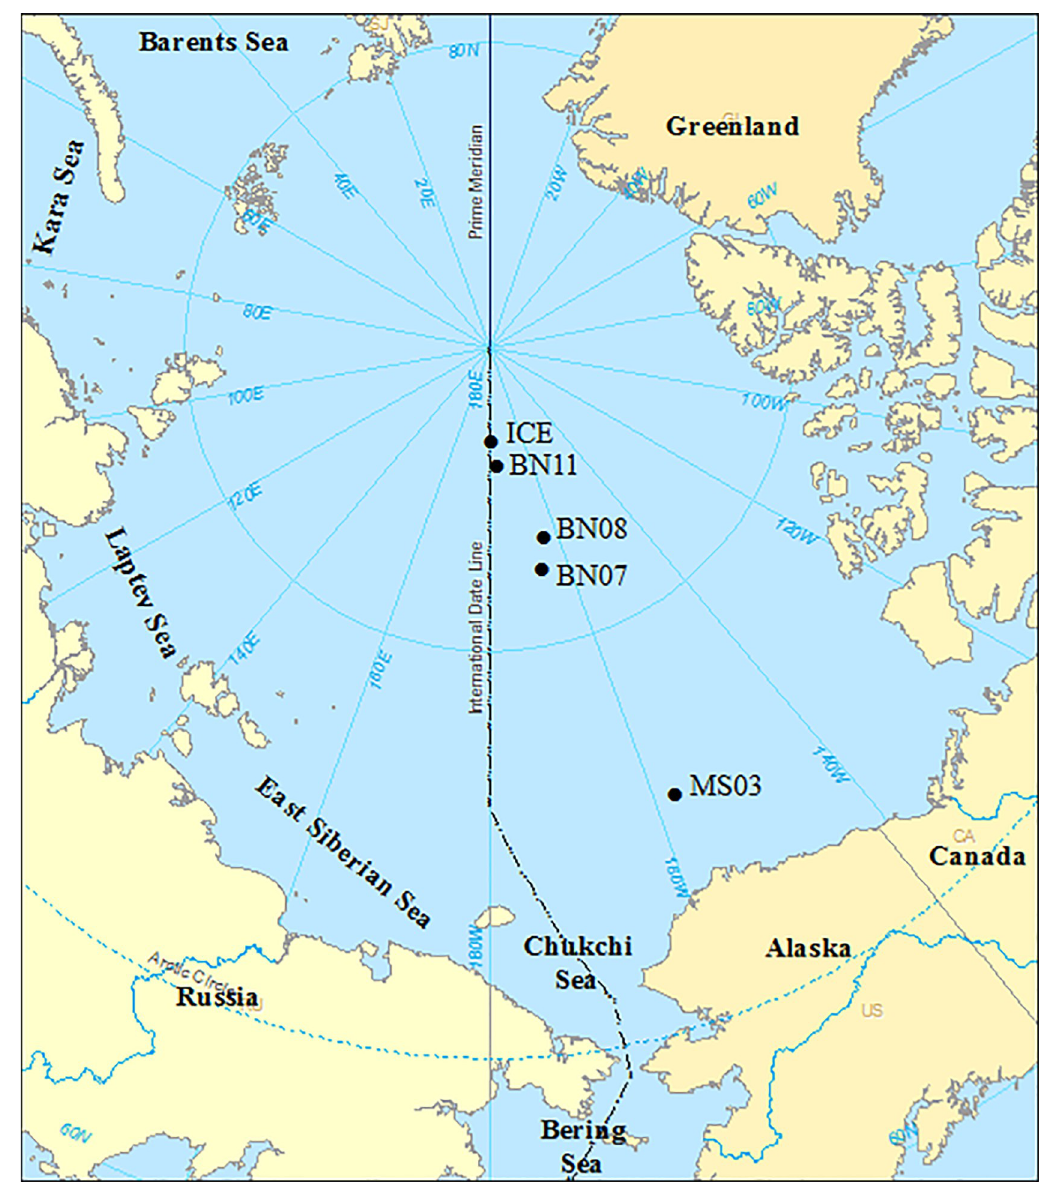
Fig 1. Map of the study area and location of sampling stations in the Amerasian Basin during the period from 28 July to 18 August 2010.